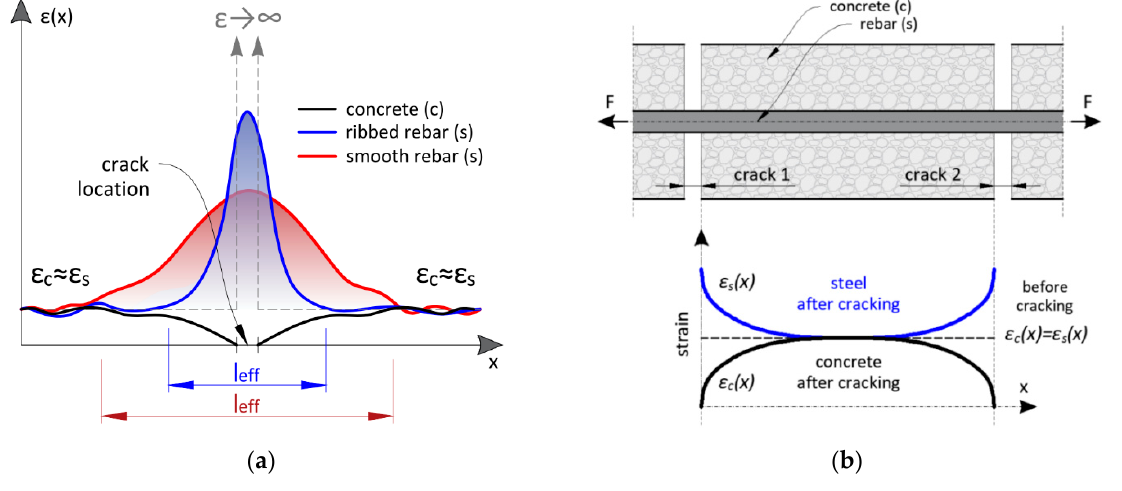
Figure 4. Strain distributions of concrete and steel rebar over length: ( a ) within the close vicinity of the crack; ( b ) within the area between the cracks.